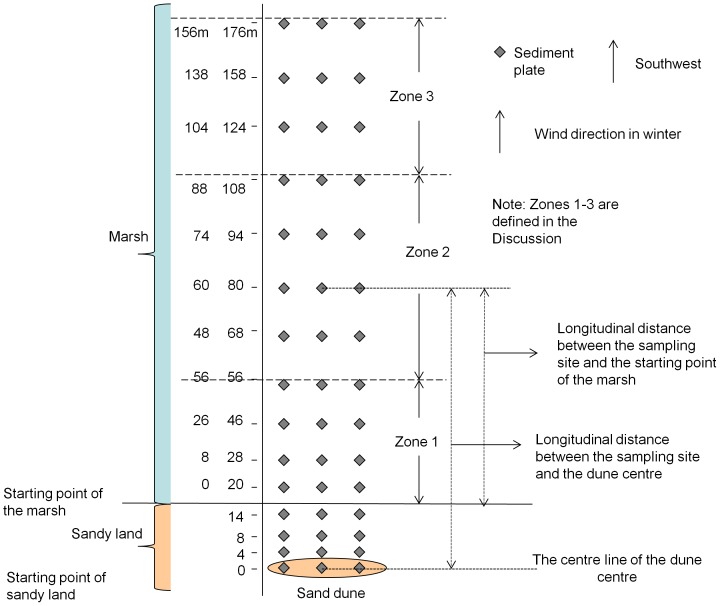
Arrangement of sampling sites in the field experiment.The sediment plate matrix (15 rows ×3 columns) was set in a marsh-sandy land transitional area. The length of the column was 176 m, while that of the row was 20 m. Four rows were set in the sandy land, and eleven rows were set in the marsh. The column length in the marsh was 156 m. The sediment plates on a column were at longitudinal distances of 0, 4, 8…, 176 m to the centre line of the dune. The plates in each row were replicates (n = 3) with the same longitudinal distance to the centre line of the dune, with a lateral interval of 10 m between each plate.